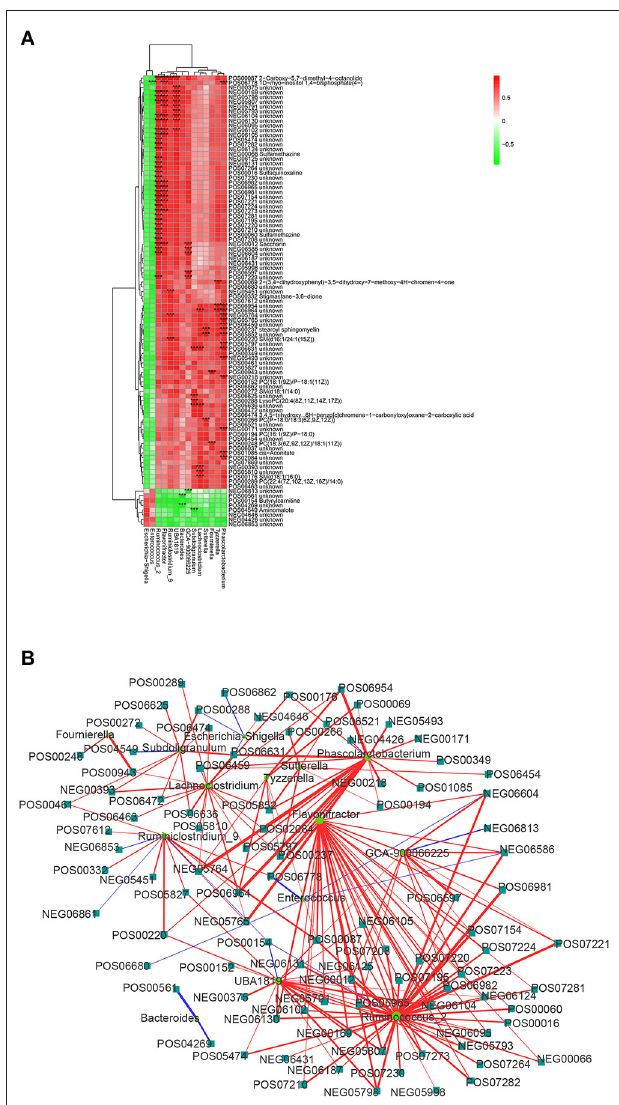
FIGURE 5 | Relationship between fecal microorganisms and plasma metabolites. (A) Heat map summarizing the correlation between significantly different fecal microbiota and significantly altered metabolites in plasma (red, positive correlation; green, negative correlation). ***Indicates the significant microbiota-metabolite correlations (|cor| > 0.75 and P < 0.01). (B) Network diagram of significant microbiota-metabolite correlations. The circle represents the altered bacteria, and the rectangle represents the altered